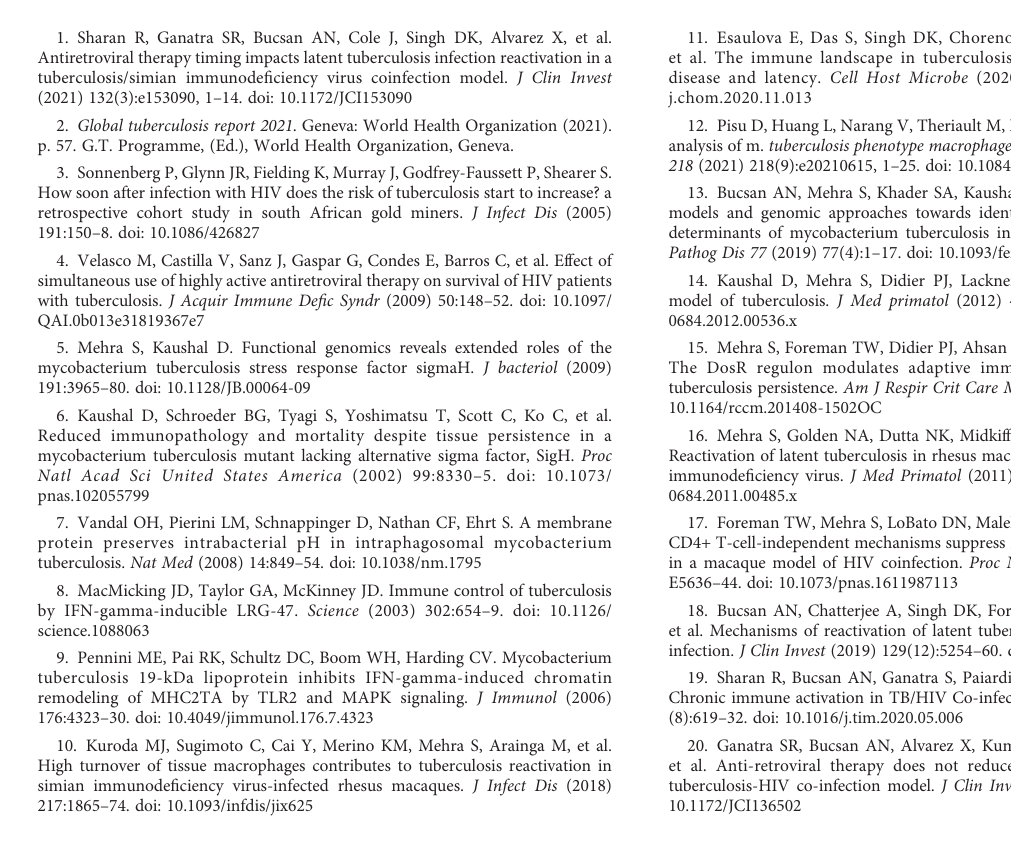
SUPPLEMENTARY FIGURE 1 Data is shown for the peripheral blood count for (A) Reticulocytes, (B) Basophils, (C) Eosinophils, (D) Red blood cells (RBCs) and (E) Platelets compared between all four cohorts, control (black), ATB(red), LTBI (green), and Mtb /SIV (blue). Data is shown for ATB (n=16), LTBI (n=11), and Mtb /SIV (n=8). Error bars represent Mean ±